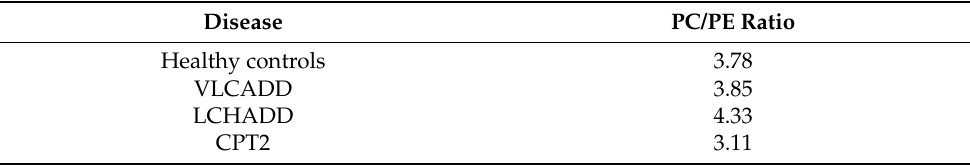
Table 2. Phosphatidylcholine to phosphatidylethanolamine ratio measured in fibroblasts from healthy controls and from VLCADD, LCHADD and CPT2D